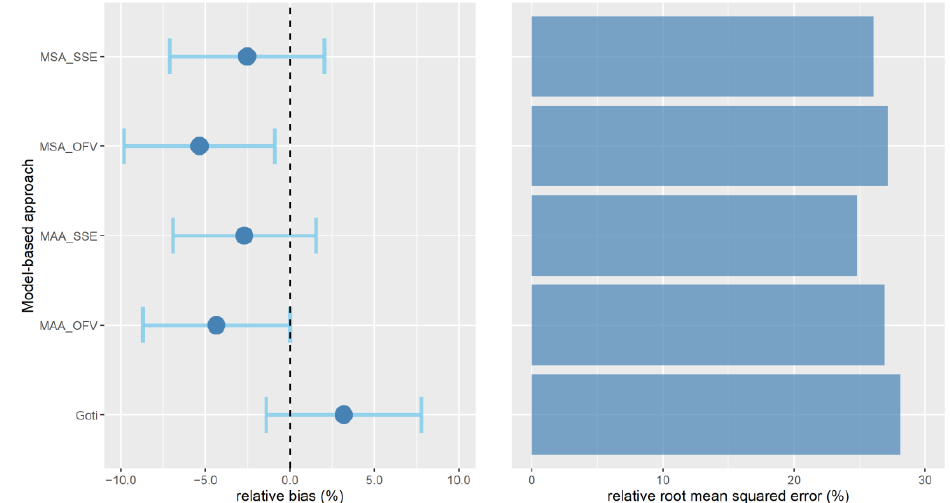
Figure 2. Overall relative bias and relative root mean square error of the predicted versus the observed second vancomycin concentration of each pair for the five model-based approaches investigated (i.e., the model selection algorithm [MSA] and the model averaging algorithm [MAA], according to the objective function value [OFV] and the squared prediction errors [SSE], and the single-model approach according to the Goti model). The blue dots represent the mean relative bias, and the blue error bars represent the 95% confidence intervals.